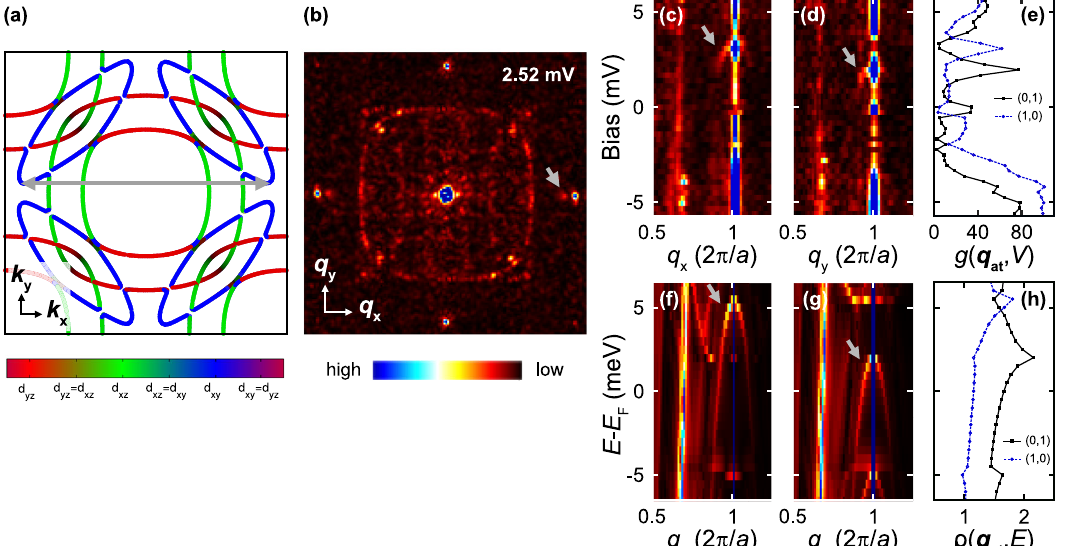
Fig. 6 QPI close to the atomic peaks. a Fermi surface from the model with surface reconstruction. The color represents the orbital character of the bands, with d xz / d yz character shown in green/red, respectively, and d xy character in blue. The gray arrow indicates the q -vector connecting the tips of the pockets of the γ -band close to the van Hove singularity. The QPI dispersion from this q -vector is expected near the atomic peaks. b Fourier transformation of a differential conductance map at V = 2.52 mV. QPI features due to the q -vector shown in ( a ) (marked by an arrow) can be observed close to the Bragg peaks at (1, 0) (in units of 2 π / a ). c , d Energy-momentum cuts through the QPI map along q x ( c ) and q y ( d ) close to (1, 0) and (0, 1). A clear dispersing feature is seen which collapses onto the atomic peak (white arrows). The dispersion differs in the q x and q y directions as a consequence of nematicity ( V set = 5.6 mV, I set = 225 pA, V L = 300 μ V, T = 76 mK, B = 6.5 T). e Differential conductance ~ g ð q at ; V Þ for the atomic peaks q at = (1, 0) and (0, 1), showing prominent features at V = 2 mV and 3 mV where the vHs crosses the zone boundary. f , g Corresponding energy-momentum cuts from the model along q x ( f ) and q y ( g ), showing the signatures of the dispersion of the scattering vectors associated with the γ band around the atomic peaks. h As in ( e ), local density of states ~ ρ ð q at ; E Þ at q at = (1, 0) and (0, 1) as a function of E . As in the experimental data, two maxima are seen due to the vHs at the zone